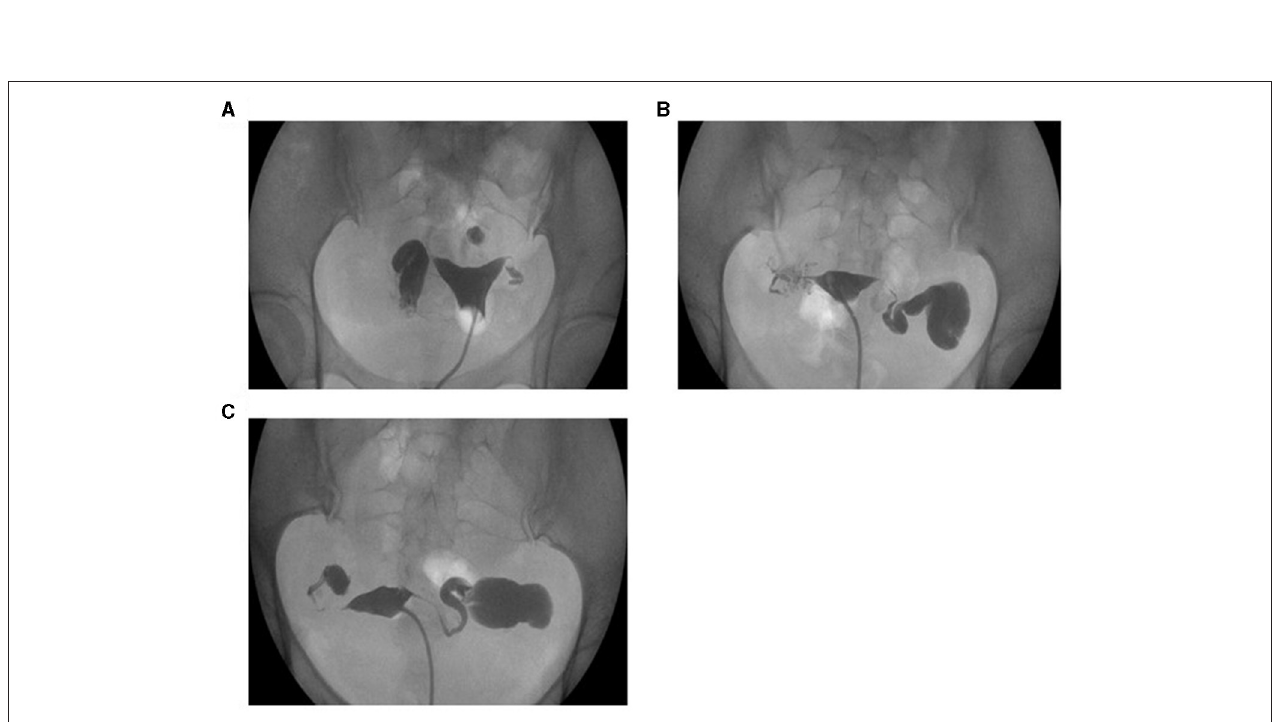
FIGURE 2 | Diagnosis of hydrosalpinx by HSG. (A) Right tube hydrosalpinx. (B) Left tube hydrosalpinx. (C) Both tube hydrosalpinx.